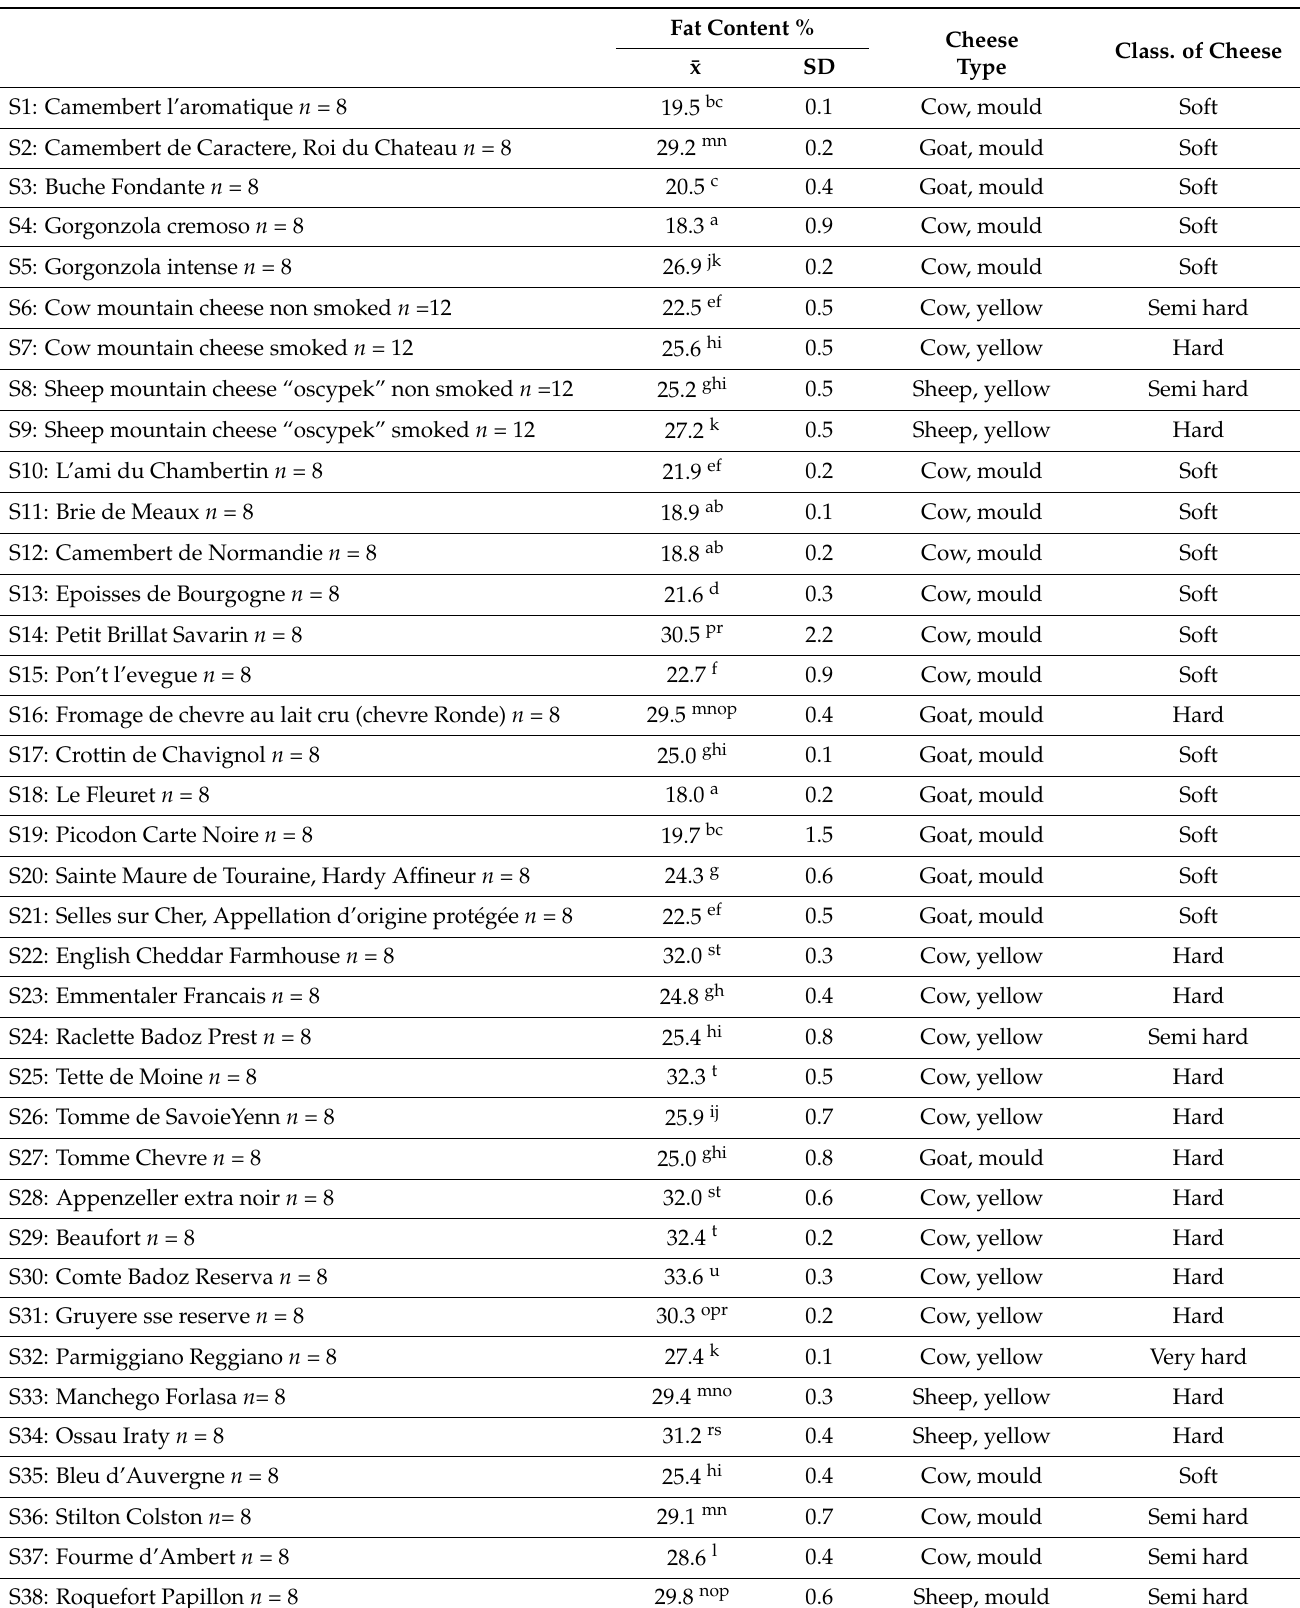
Table 1. Classification, type, and fat content of studied cheeses.